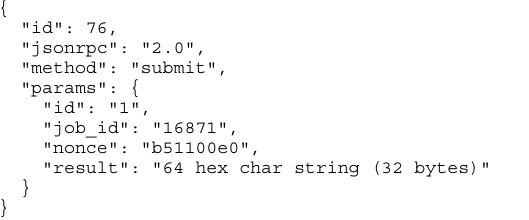
completed. The nonce (8 hexadecimal characters denot-